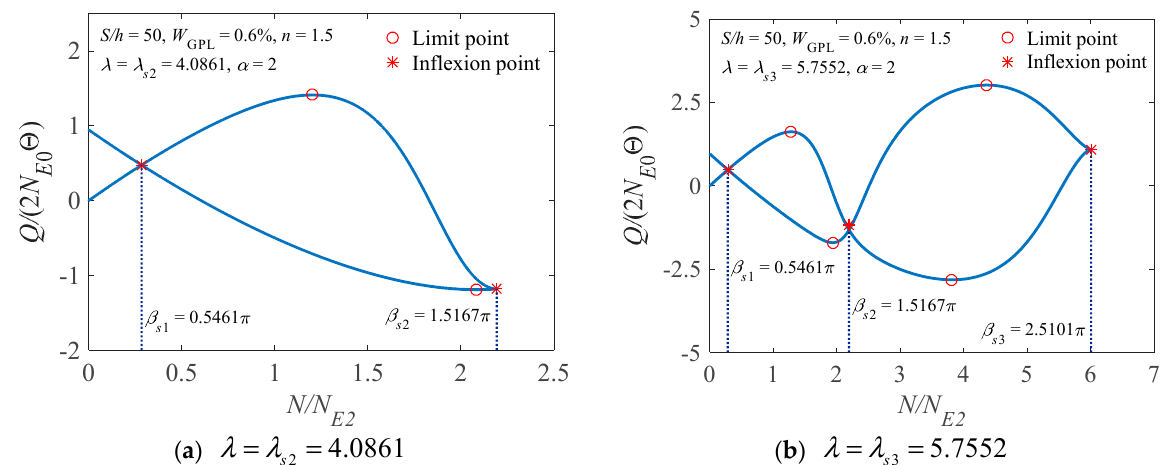
Figure 10. Nonlinear load-axial force curve of an elastically restrained FG-GPLRC arch.